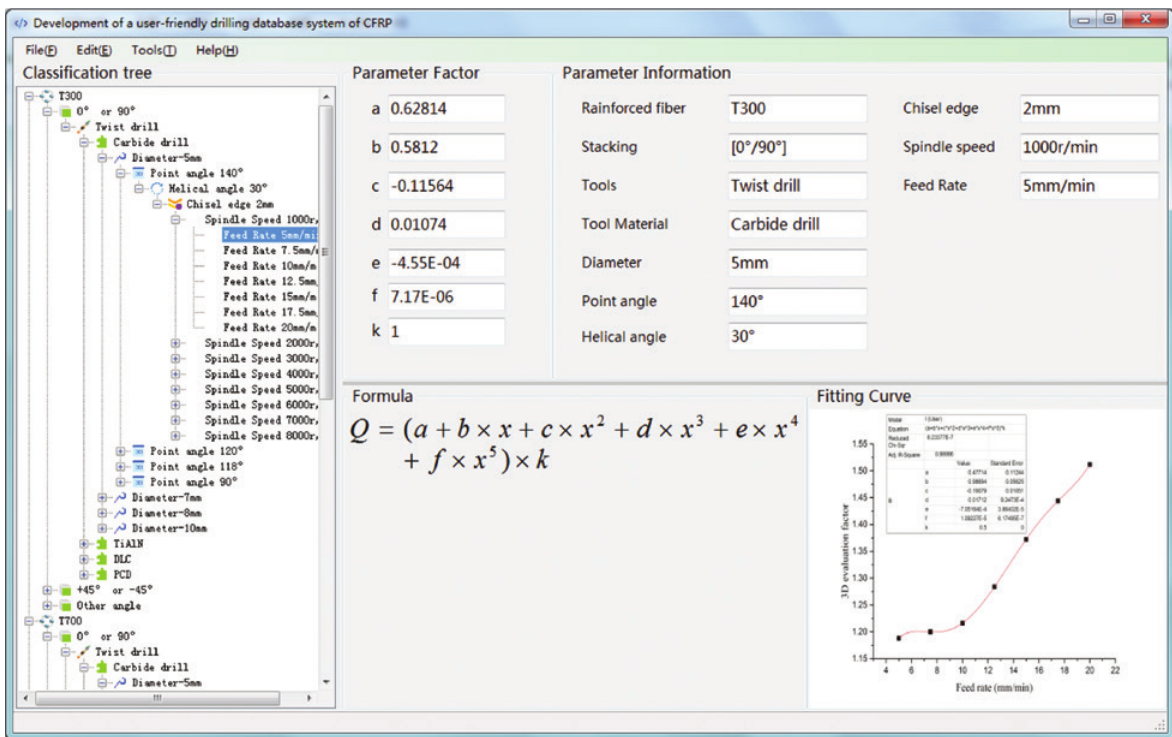
Figure 8: Development of a user-friendly drilling database system of CFRP.